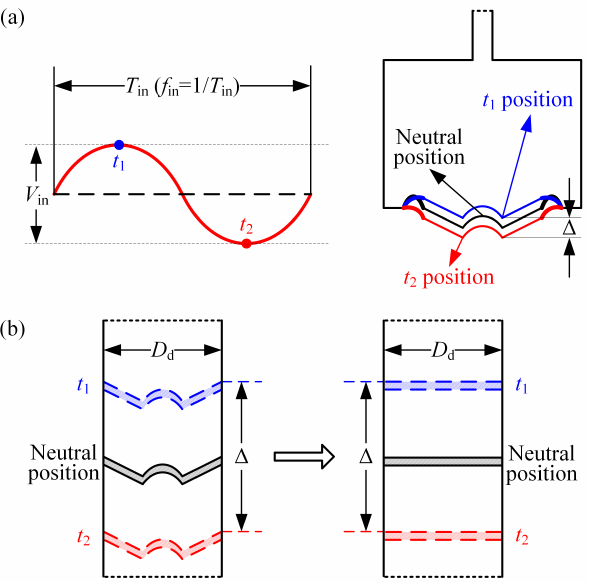
Figure 7. Volume variation of the cylindrical cavity: ( a ) input signal and schematic of the movement of oscillating diaphragm; ( b ) volume variation equivalence of the cylindrical